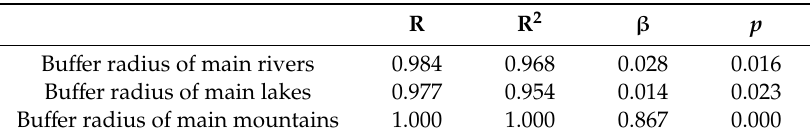
Table 5. Regression